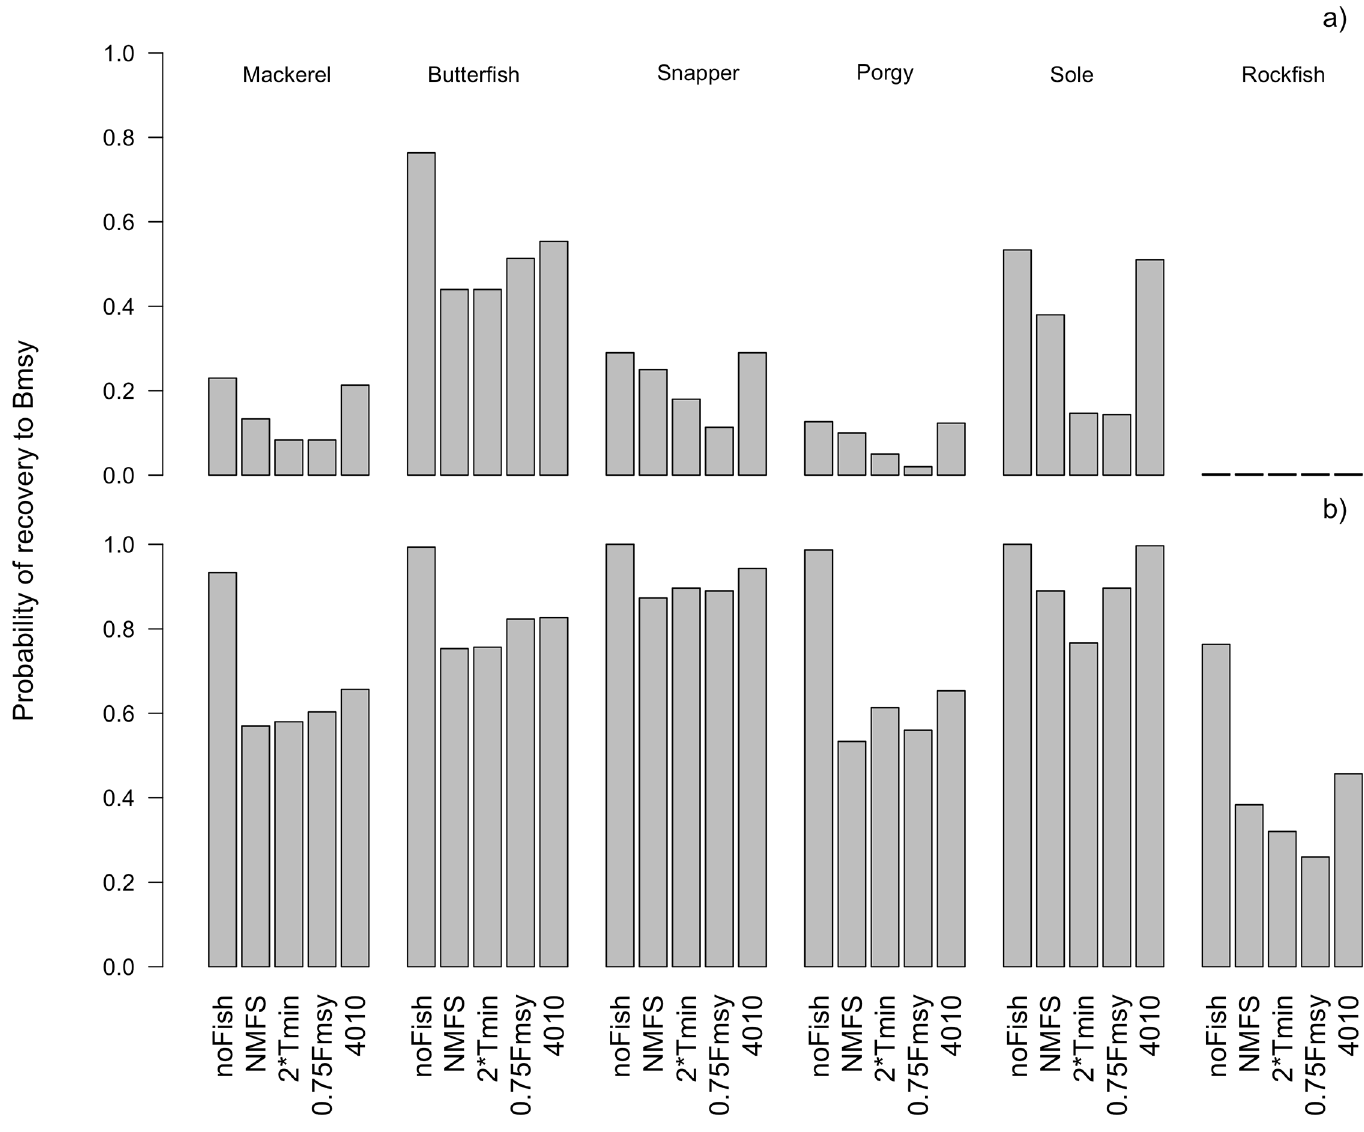
Fig 1. Probability of rebuilding to B MSY in the first 10 years (a) and 40 years (b) of the simulation projection period for all species and management procedures using the Baseline model